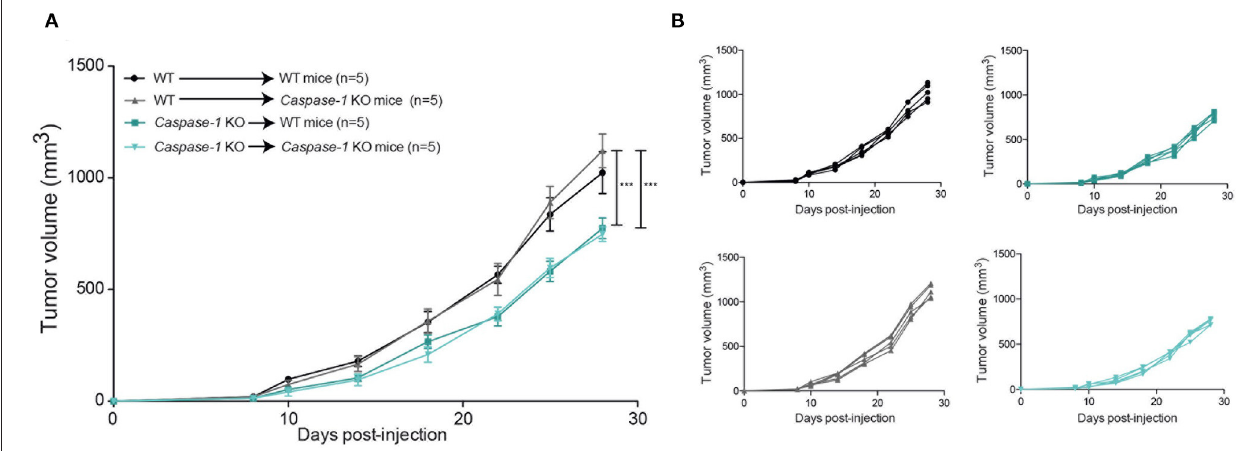
FIGURE 3 | The presence of the inflammasome in the hematopoietic compartment promotes mammary tumor growth. Irradiated mice of indicated genotypes were grafted with bone marrow stem cells from WT or Caspase-1 KO mice and were injected with 4T1 mammary tumor cells 28 days later. (A) Tumor growth was measured over 30 days. (B) Individual growth curves depicted in A. Data represent mean ± SD *** P < 0.001 (Two-way ANOVA analysis).